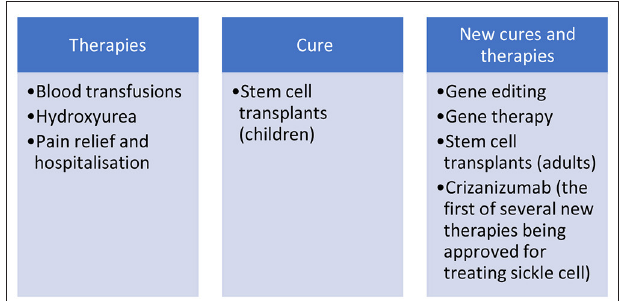
FIGURE 2 | Simplified version of therapies and curative options for sickle cell